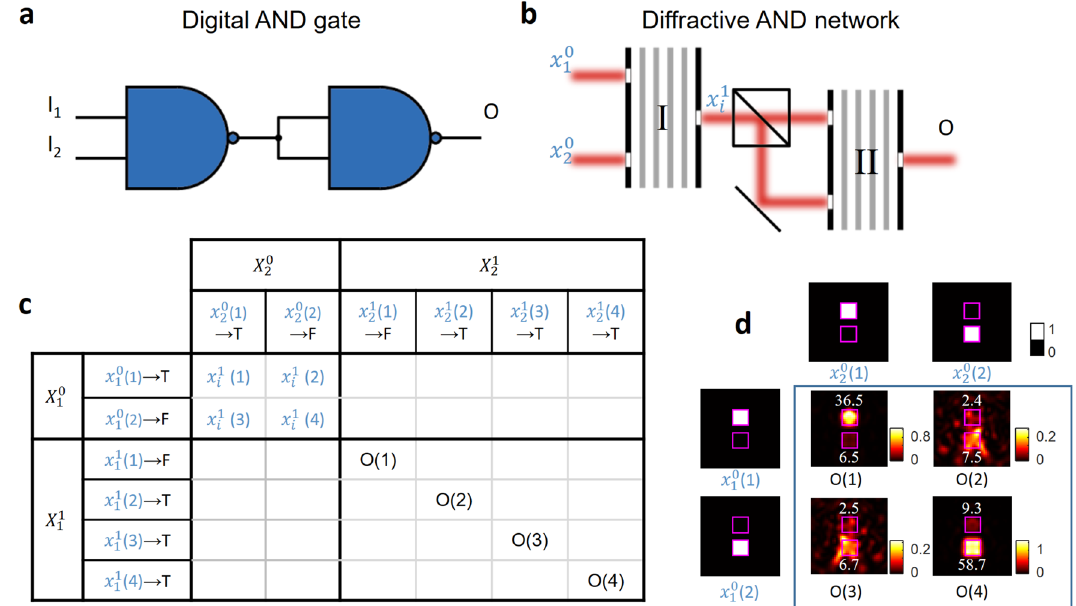
Figure 3. Logical AND operator that is composed of cascaded diffractive NAND gates. ( a ) Digital implementation of an AND operator using NAND gates. ( b ) All-optical AND gate design that is composed of cascaded diffractive NAND gates. ( c ) A portion of the design map (Fig. 2b) showing the correctness of the intermediate all-optical calculation steps ( x 1 i ) and the output of the AND gate (O) under different input combinations. ( d ) The intensity profiles at the output plane of the final diffractive NAND gate. The inserted numbers in white font color indicate the relative optical signal within each aperture. Each input optical logical value is assumed to have a relative optical signal level of 256 (a.u.), defining the ideal signal level per